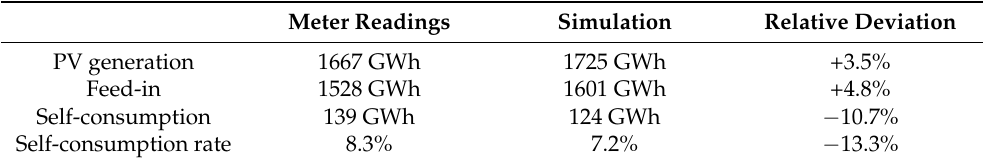
Table 3. Comparison of the annual meter readings with the corresponding simulated energy sums. Here, feed-in integrates feed-in both under FIT and for direct marketing. The relative deviation is the difference between simulation and the reading normalized by the reading value.